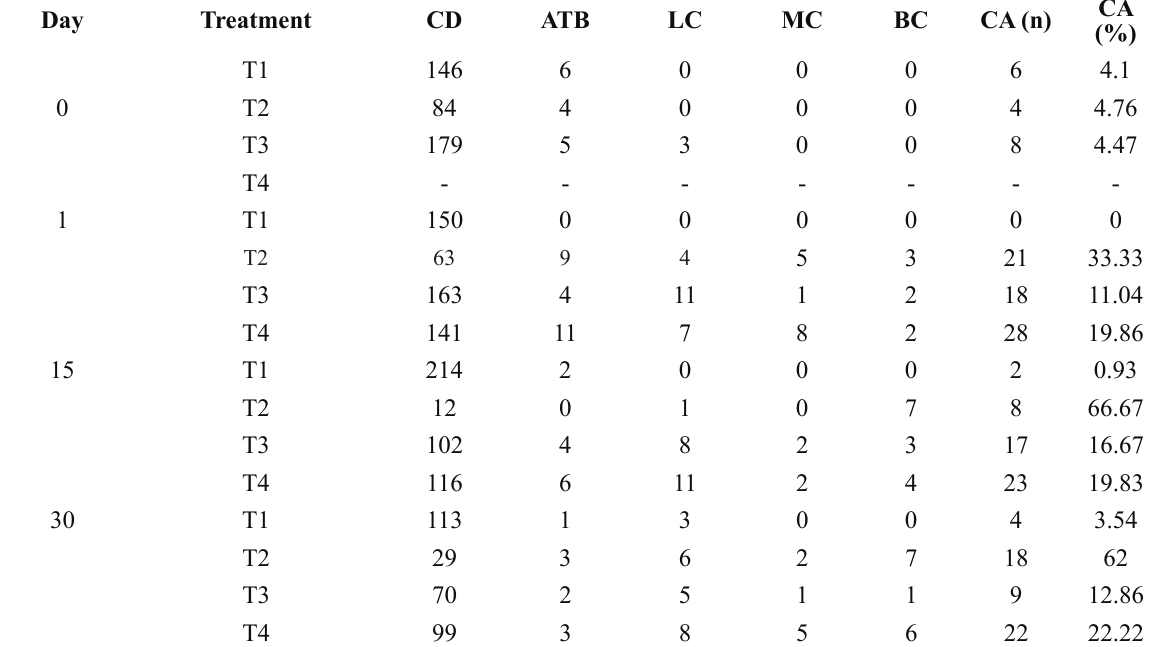
Number of Allium cepa cells in cell division and chromosomal abnormalities. Santa Maria,